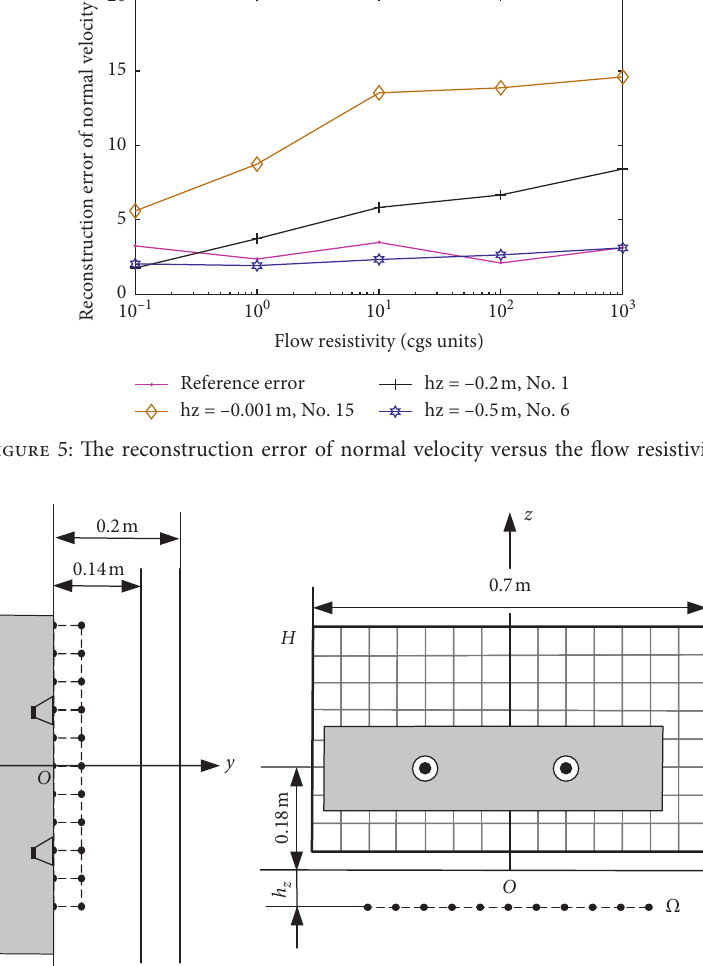
1 and H 2 , and the fictitious surface Ω . (a) Top view. (b) Side